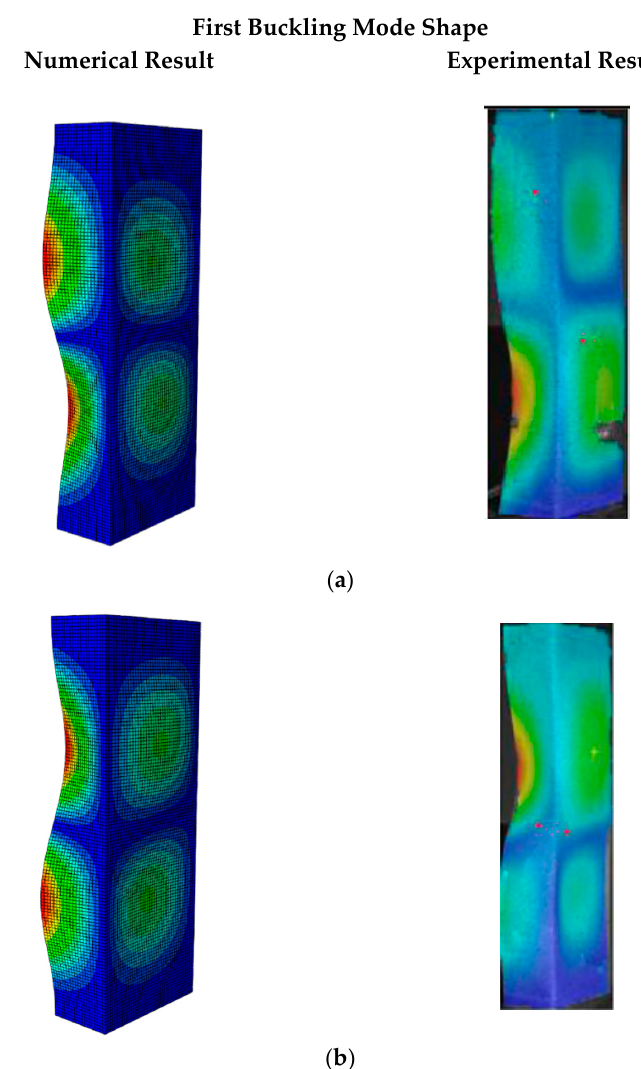
Figure 8. Linear buckling mode shape of the numerical result and experiment result. ( a ) Quasi-isotropic laminate. ( b ) Angle-ply laminate.